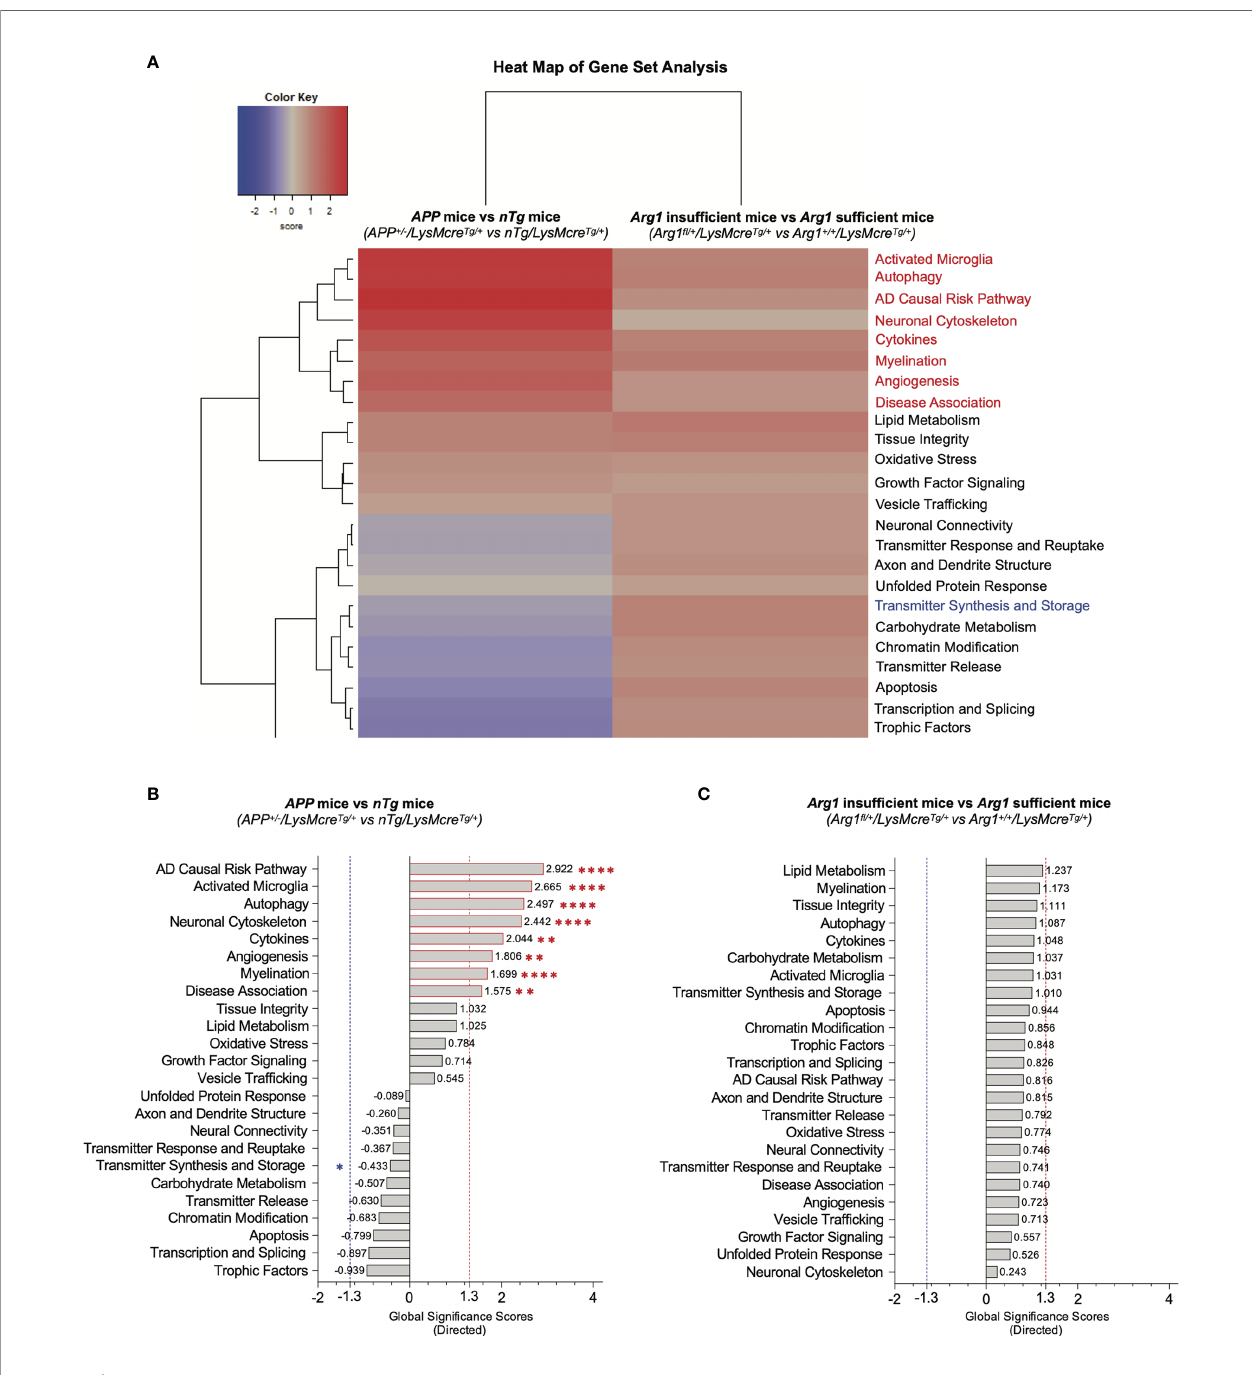
FIGURE 3 | Gene set analysis for measuring overall pathway differential expression. (A) A heat map of directed global signi fi cance scores (GSS) against covariate of APP transgene genotype ( APP +/- /LysMcre Tg/+ vs nTg/LysMcre Tg/+ ) and Arg1 haploinsuf fi ciency genotype ( Arg1 fl /+ /LysMcre Tg/+ vs Arg1 +/+ /LysMcre Tg/+ ). All gene sets are presented on the same scale via a z -transformation. Gene sets that show statistically signi fi cant main APP transgene genotype effects from pathway scoring analysis are highlighted in red or blue to indicate up or down-regulation, respectively. (B) A bar graph of APP transgene genotype ranks all signature pathways with directed GSS values. (C) A bar graph of Arg1 haploinsuf fi ciency genotype ranks all signature pathways with directed GSS values. The up or down regulated pathway is indicated by positive or negative GSS values, respectively. The red or blue dashed line highlights the up or down regulated pathways based on the cut-off criterion (absolute GSS value at 1.3). Also, the statistically signi fi cant pathways of main APP transgene genotype effect identi fi ed in pathway scoring analysis are additionally annotated with red or blue asterisk sign (*). * p < 0.05; ** p < 0.01; **** p <